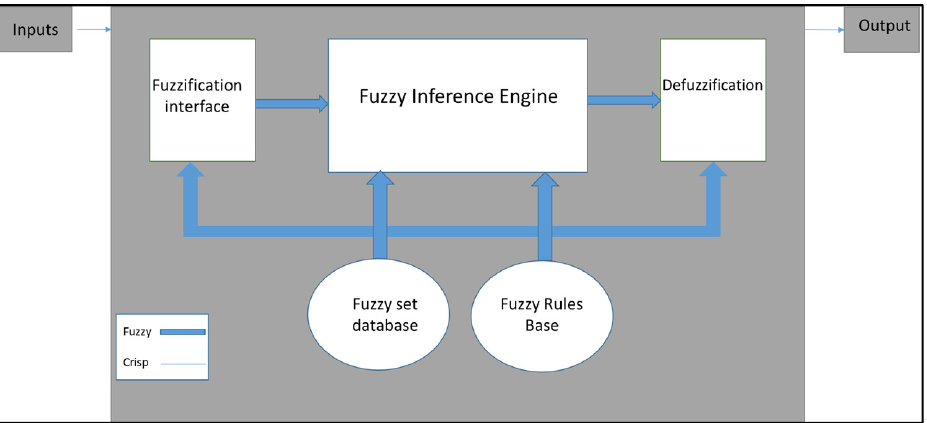
Figure 8. Fuzzy inference system.